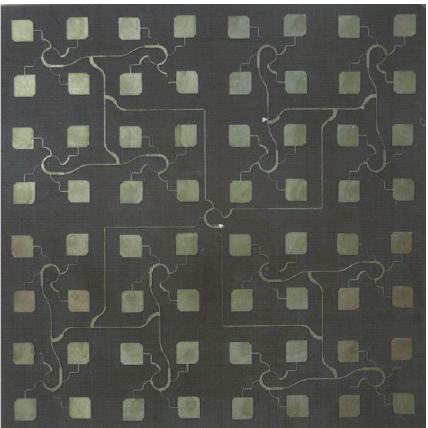
Figure 6: Photograph of 64-element CP antenna array with the proposed double sequential rotation feeding network [12].